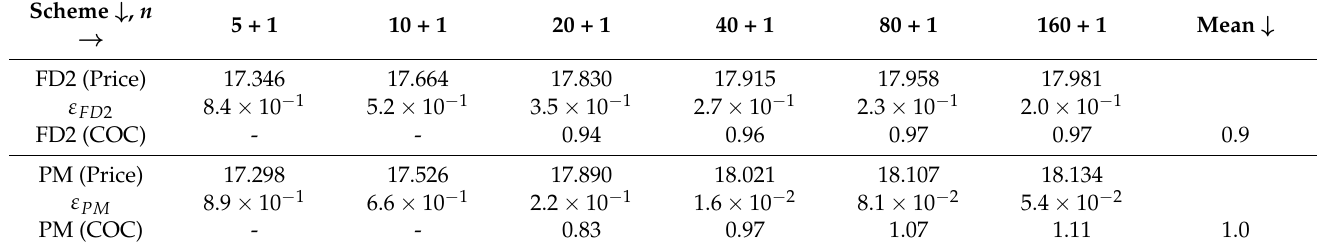
Table 2. Temporal COCs for different schemes under Test Problem 1.